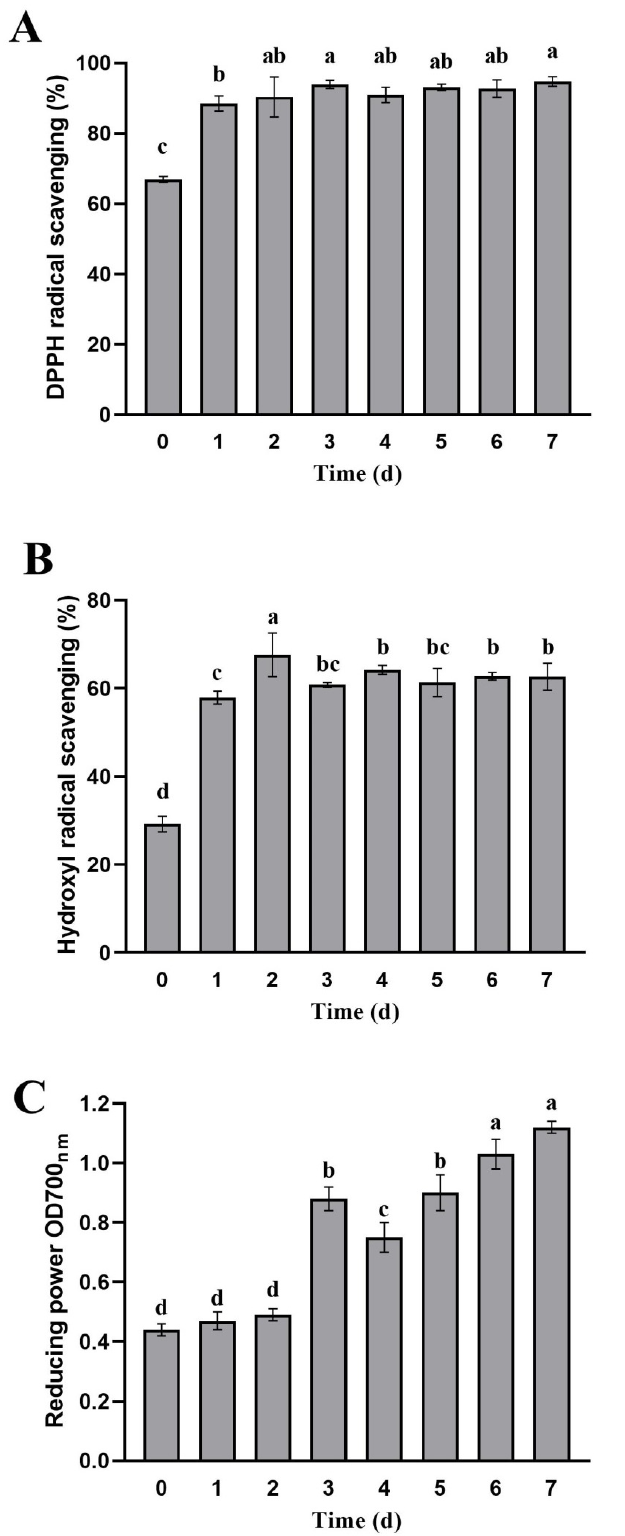
Figure 6. Antioxidant activities of apple pomace during fermentation. ( A ) DPPH radical scavenging activity; ( B ) hydroxyl radical scavenging activity; ( C ) reducing power. Data are means ± SD of three biological replicates. Different letters above bars indicate significant differences ( p <